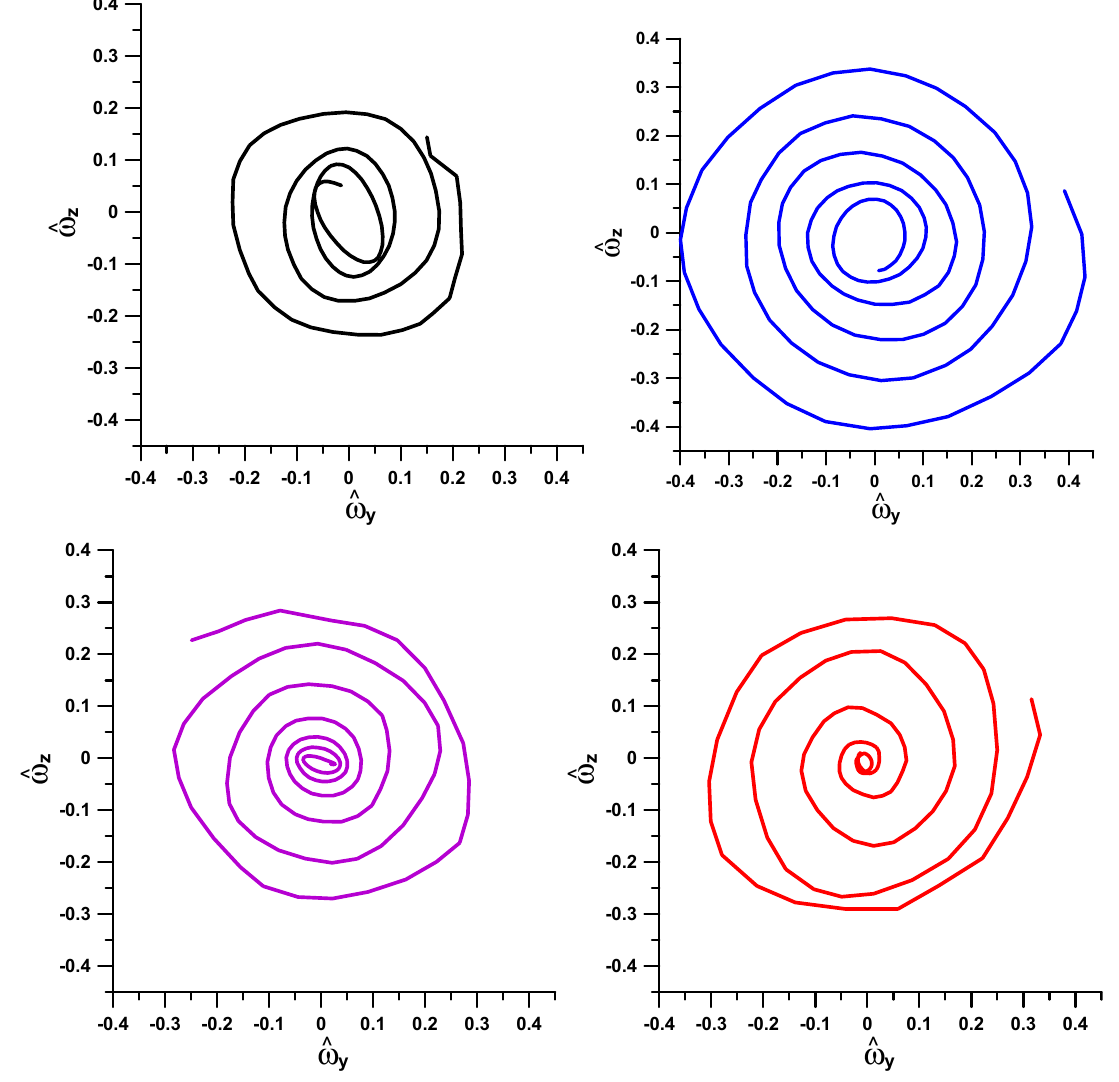
Figure 2. z-component of the angular velocity ( ω z ) unit vector against the y-component ( ω y ) unit vector projected on the plane of the Frisbee, i.e., yz plane), of the flight phases of 4 different Frisbee throws; the outermost starting point is the release point of the